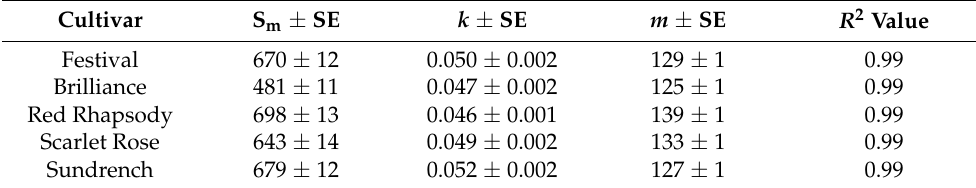
Table 5. Details of the relationships between the seasonal changes in accumulated marketable yield and day since planting in the five strawberry cultivars in Queensland shown in Figure 1.